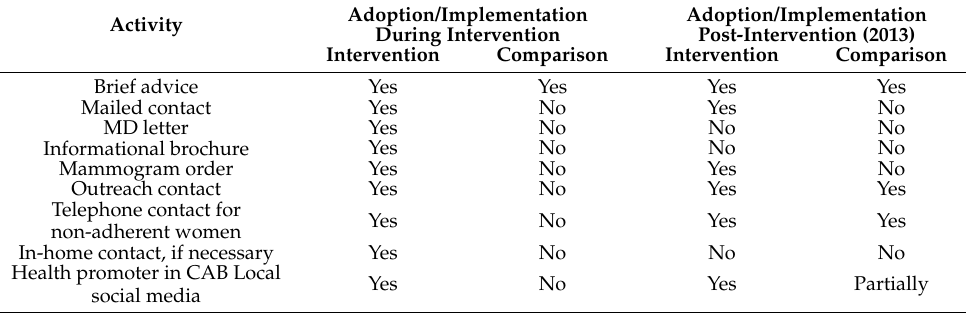
Table 2. Activities during adoption and